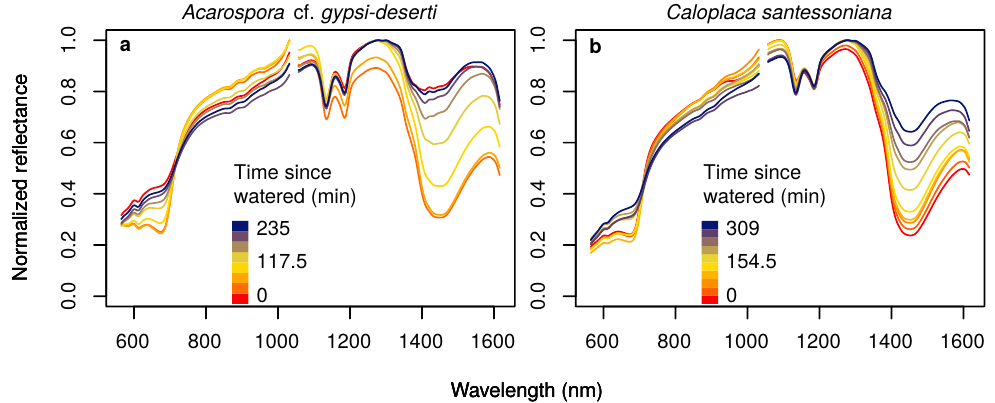
Figure 3. Hyperspectral reflectance of Acarospora cf. gypsi-deserti ( a ) and Caloplaca santessoniana ( b ) in the dry condition (red) and after being artificially watered in the laboratory (orange to blue colors), measured with the spectrometer.